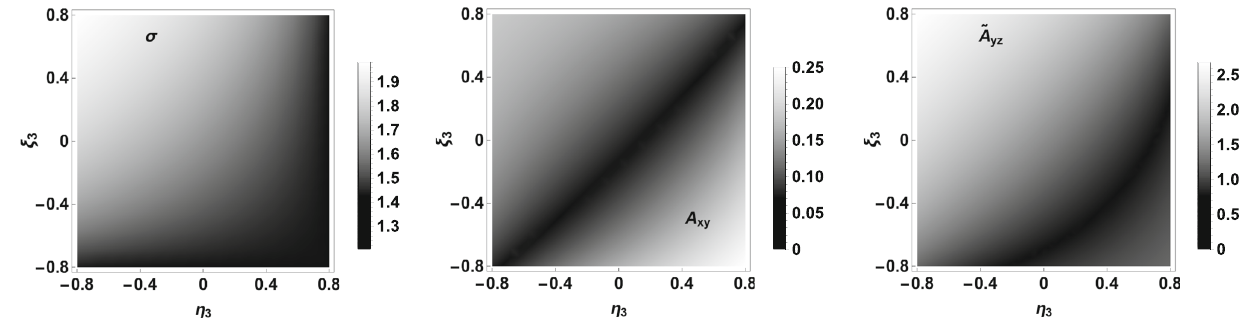
Fig. 3 Effect of beam polarizations on sensitivity of cross section σ , A xy and (cid:3) A yz in the process e + e − → Z Z for anomalous couplings f = {+